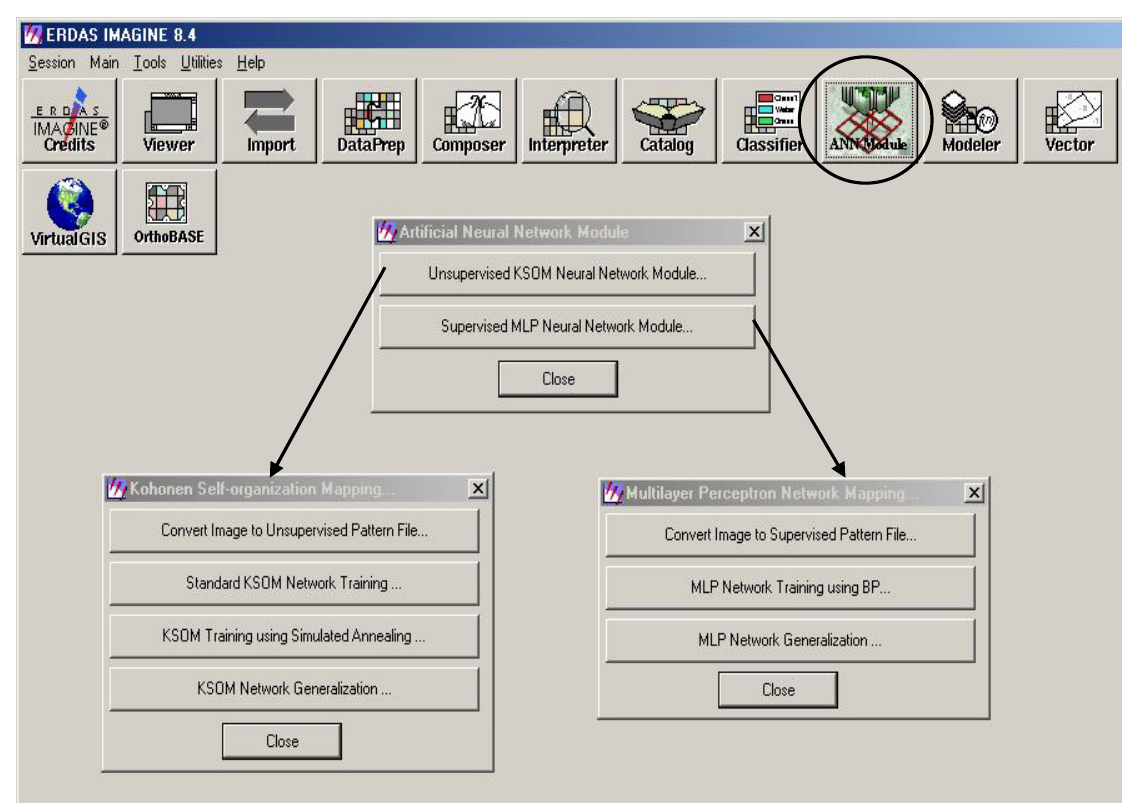
Figure 4. Main interface of the ANN